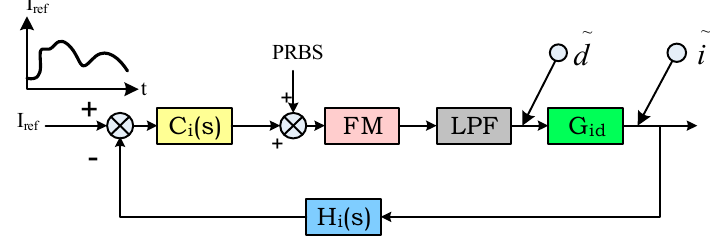
Figure 10. Plant identification using PRBS under close-loop conditions.